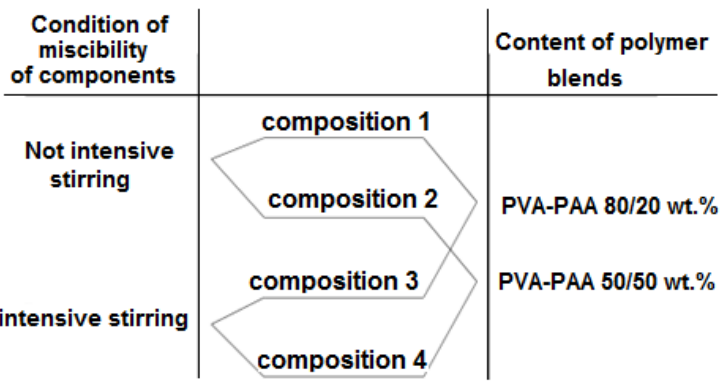
Figure 2. Preparation conditions for PVA-PAA compositions.